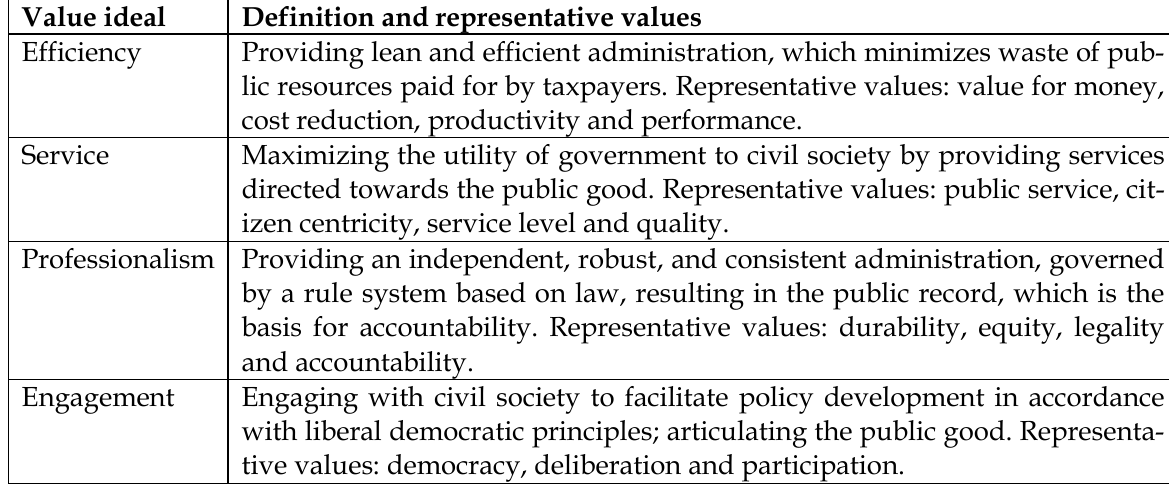
Table 1. Four value ideals for e-government management (adapted from Rose et al., 2015, p. 542) (Toll et al.,